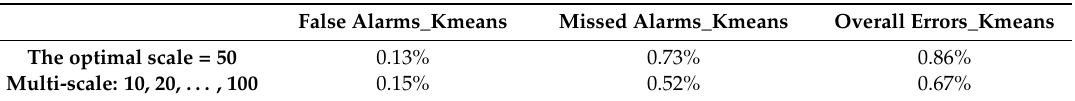
Figure 10. Overall errors of the change detection with different segmentation scales, with L2 as the basis image in the first study area. Table 5. Comparison between the change detection results of the single-scale and multi-scale proposed method, with L2 as the basis image in the first study area.